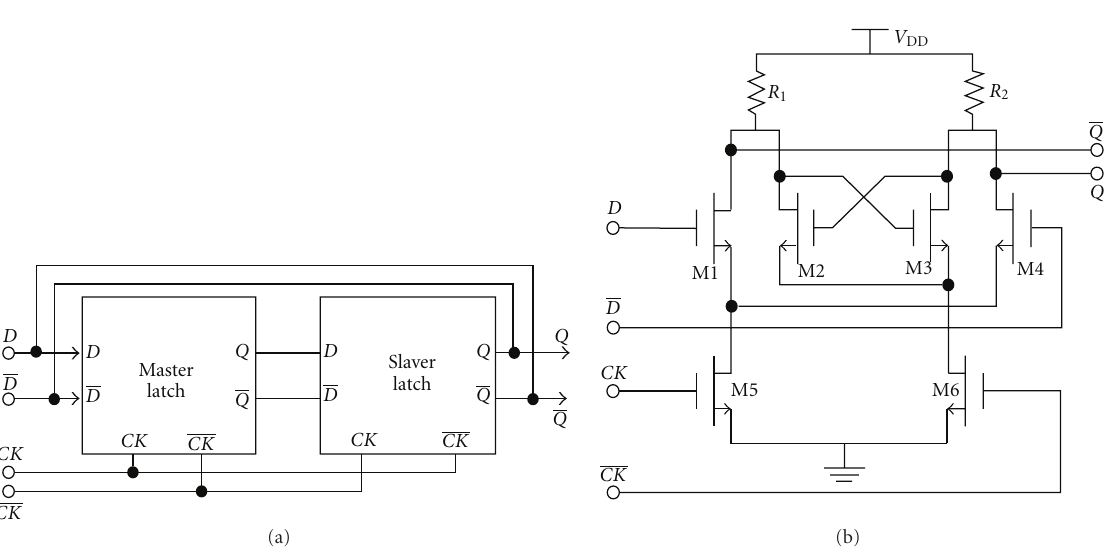
Figure 6: (a) Block diagram of divide-by-2 SCL divider, (b) circuit schematic of D-latch.